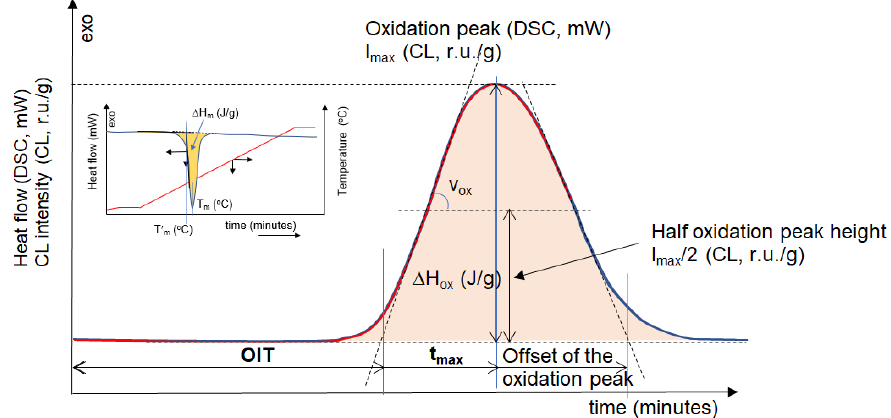
Figure 1. Typical isotherm curves of oxidation in DSC and CL measurements indicating the kinetic parameters that can be calculated from these curves: OIT, t max (time to maximum of oxidation peak in either DSC and CL), and t 1/2 (time to reach half of the oxidation peak) are the main parameters used in this work; other parameters include the oxidation rate (v ox = the slope of the tangent at the inflexion point of the ascendent peak edge), offset of the oxidation peak, and the thermal effect of oxidation ( ∆ H ox ). The inset shows a typical thermogram of the non-isothermal heating (10 ◦ C/min) of a polyethylene sample in an inert (nitrogen) atmosphere in DSC; the melting endotherm can be observed; the parameters used for characterization of the melting process are the melting temperature (T m or T (cid:48) m ) and the melting endotherm ( ∆ H m ). For DSC measurements, the samples (either as thin chops or slices with 0.2 mm thickness cut with a Jasco HS-1 vertical slicer (Jasco Corp., Tokyo, Japan)) were